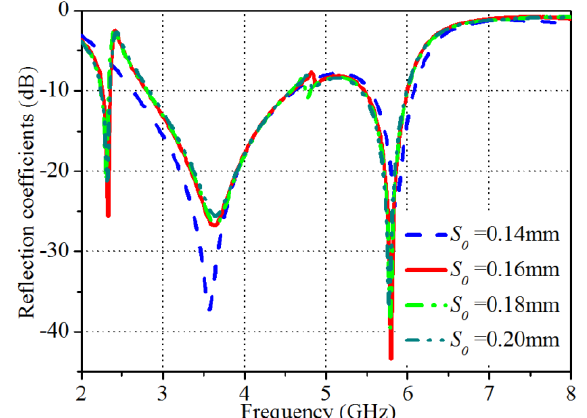
Figure 9 : Radiation efficiency of the proposed